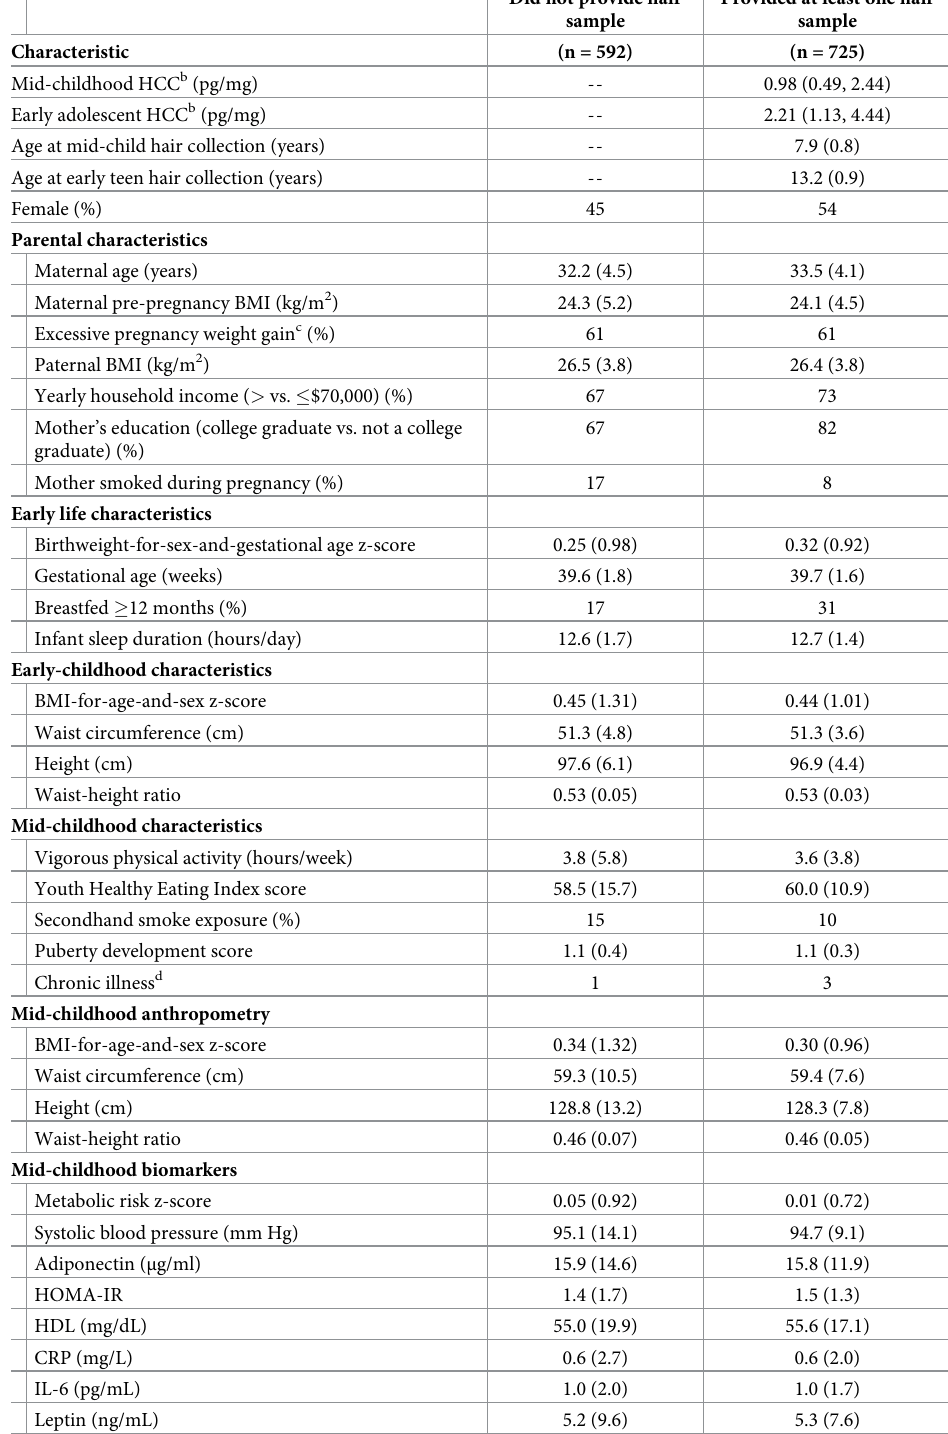
Table 1. Characteristics a of White Project Viva participants who provided and did not provide at least one hair